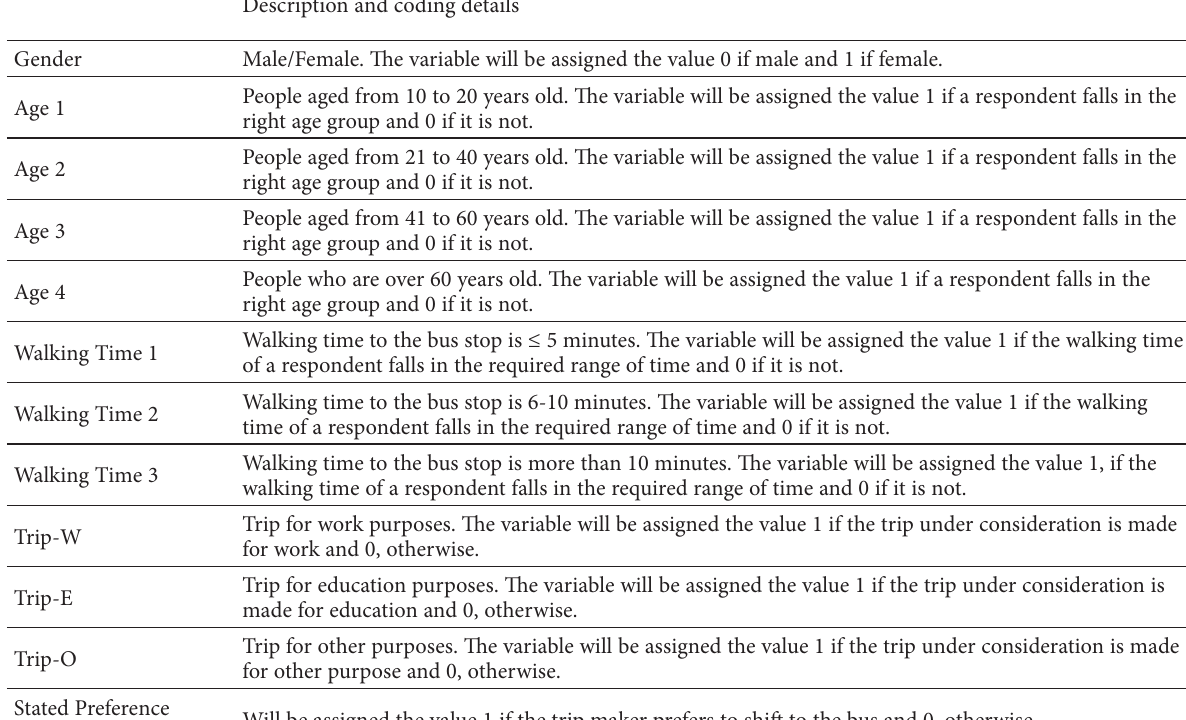
Table 1. Description of the variables considered for modeling Variable name Description and coding details